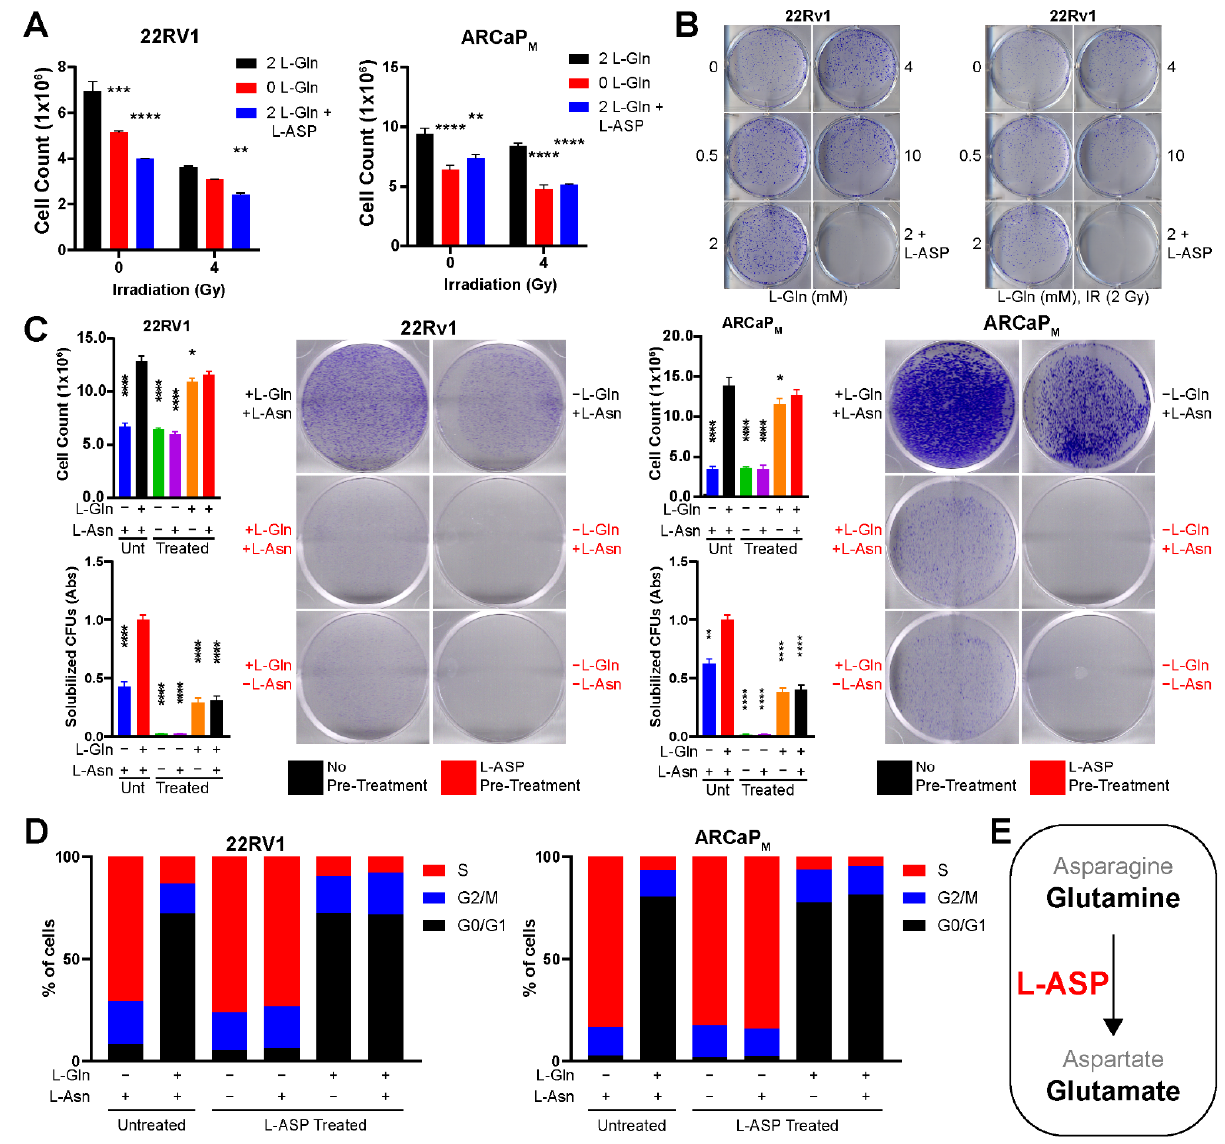
Figure 2. L-ASP reduces viability of PCa cells through depletion of glutamine, not asparagine. ( A ) 22RV1 and ARCaP M cultured cells were counted following the indicated dose of irradiation in the context of L-Gln (0 or 2 mM) and/or L-ASP (0 or 2 IU/mL). ( B ) Clonogenic assays with 22RV1 cells were quantitated following 0 or 2 Gy of radiation, in the presence of increasing levels of L-Gln (0. 0.5, 2, 4, and 10) or 2 mM L-Gln with 2 IU/ mL L-ASP. ( C ) Clonogenic assays of 22RV1 and ARCaP M cells were performed 10 days after administering untreated or L-ASP-treated media. L-Gln and L-Asn was added back to L-ASP-treated media. Cell counting shows short-term effects (72 h) under the same conditions. ( D ) Cell cycle analysis was performed on 22RV1 and ARCaP M cells following incubation under control conditions or treatment with L-ASP-treated media for 72 h. ( E ) Graphic shows that L-ASP effects in PCa cells by the depletion of extracellular glutamine, not asparagine. Cell counts are reported as a mean ± SD (* p < 0.05, ** p < 0.01, *** p < 0.001, **** p < 0.0001, compared to control).